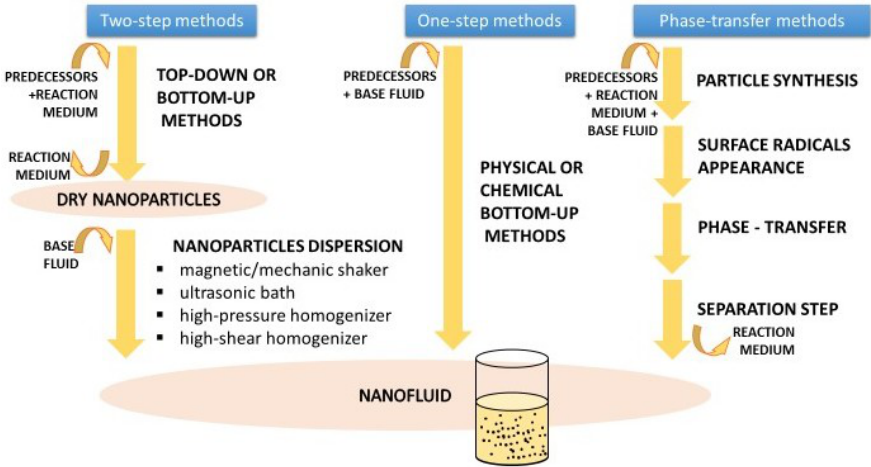
Figure 4. Available preparation methodologies for nanofluids.